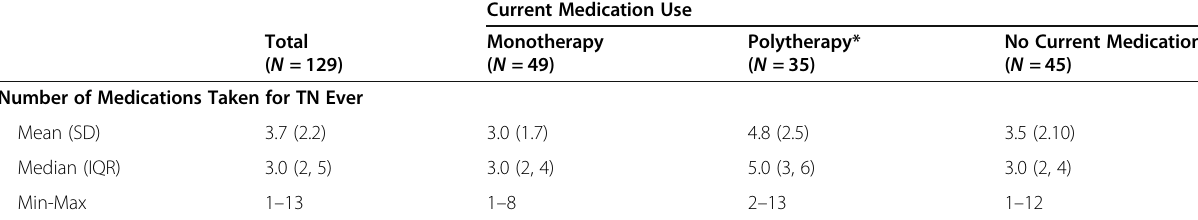
Table 4 Historical Medication Use for TN